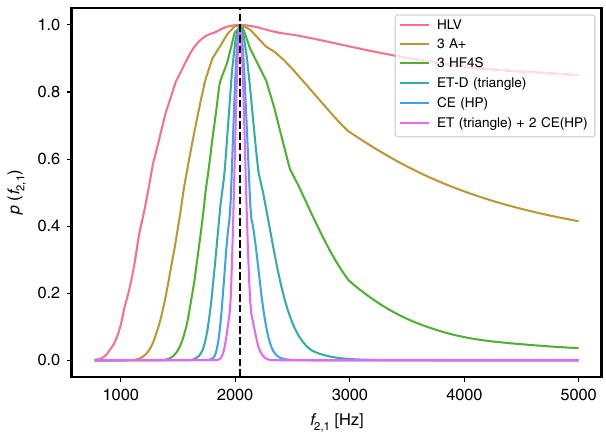
Fig. 2 1D posterior probability for the f 2 -mode frequency of a GW170817- like binary in different detector networks. The vertical dashed line indicates the true value of f 2 = 2.04 kHz for the larger mass. The detector networks considered are: LIGO-Virgo at design sensitivity (HLV), three A + detectors 28,29 , three 4 km L-shaped LIGO detectors with improved high- frequency sensitivity 30,31 (HF4S), one triangular Einstein Telescope D- con fi guration, one Cosmic Explorer (CE) and a network consisting of two CEs and one